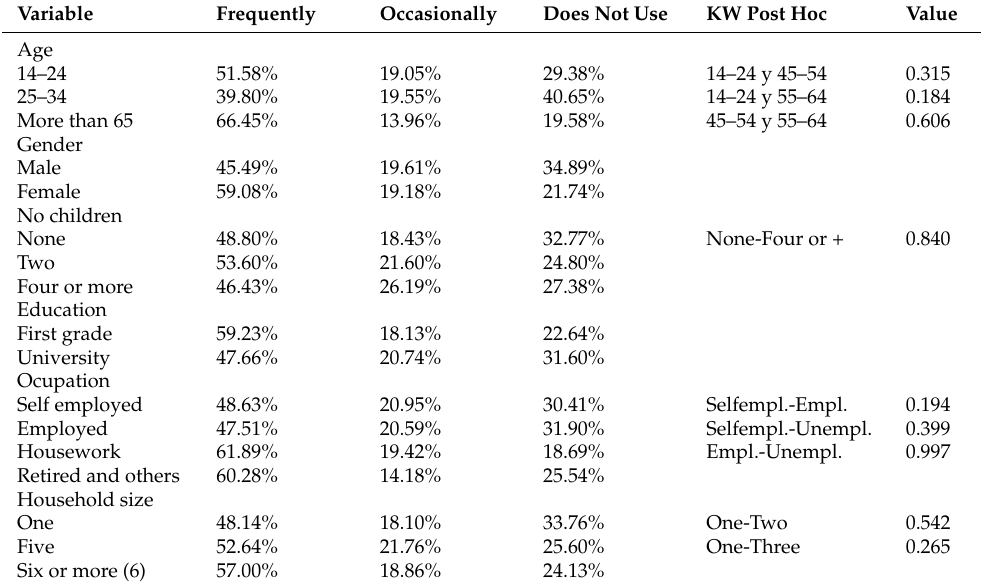
Table 7. Use of ad-blockers for independent variables,